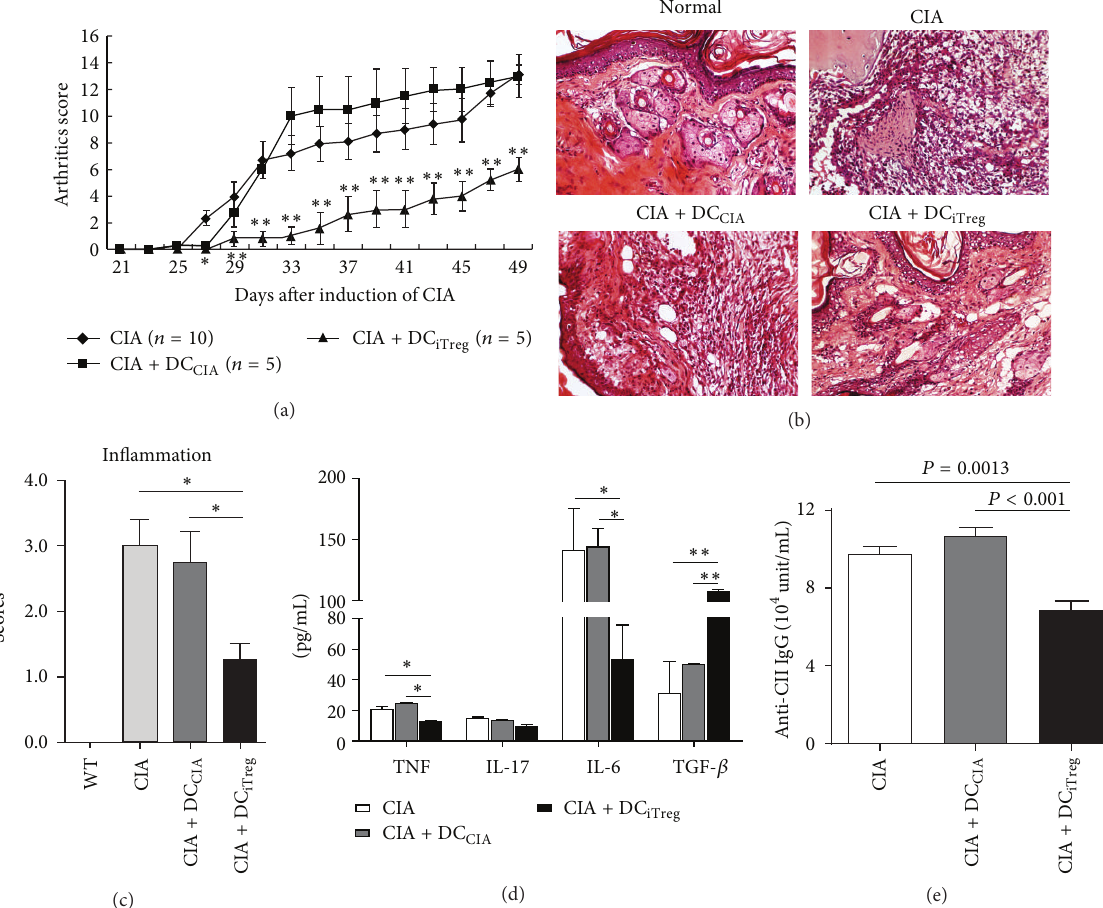
Figure 3: The adoptive transfer of iTregs induced a significant inhibitory effect of splenic DCs on CIA. DC and DC were pulsed with CIA iTreg CII peptide and adoptively transferred into CIA mice at the same density ( 5 × 10 5 /animal). (a) Each group of mice ( 𝑛 = 10 ) was scored for clinical signs of arthritis. The arthritic scores following the adoptive transfer of different DCs are shown. ∗ 𝑃 < 0.05 , ∗∗ 𝑃 < 0.01 compared -treated group and DC -treated group/untreated CIA group. (b) Hind paws were collected 3 weeks after the onset of CIA. The with DC iTreg CIA tissue was stained with H&E to visualize synovial joint inflammation. (c) The histopathological scores of inflammation were expressed as the means ± SEM of five independent experiments. ∗ 𝑃 < 0.05 compared with the indicated groups using unpaired t -tests. (d) Serum was collected from each group of mice 3 weeks after the onset of CIA. Serum levels of TNF- 𝛼 , IL-17, IL-6, and TGF- 𝛽 were measured using CBA and ELISA assays. The data are reported as the means ± SEM. ∗ 𝑃 < 0.05 , ∗∗ 𝑃 < 0.01 compared with the indicated groups using unpaired t -tests. The results of five replicated independent experiments were pooled. (e) Serum levels of total CII-specific immunoglobulin in each group of mice were determined using ELISA. The results of five replicated independent experiments were pooled.